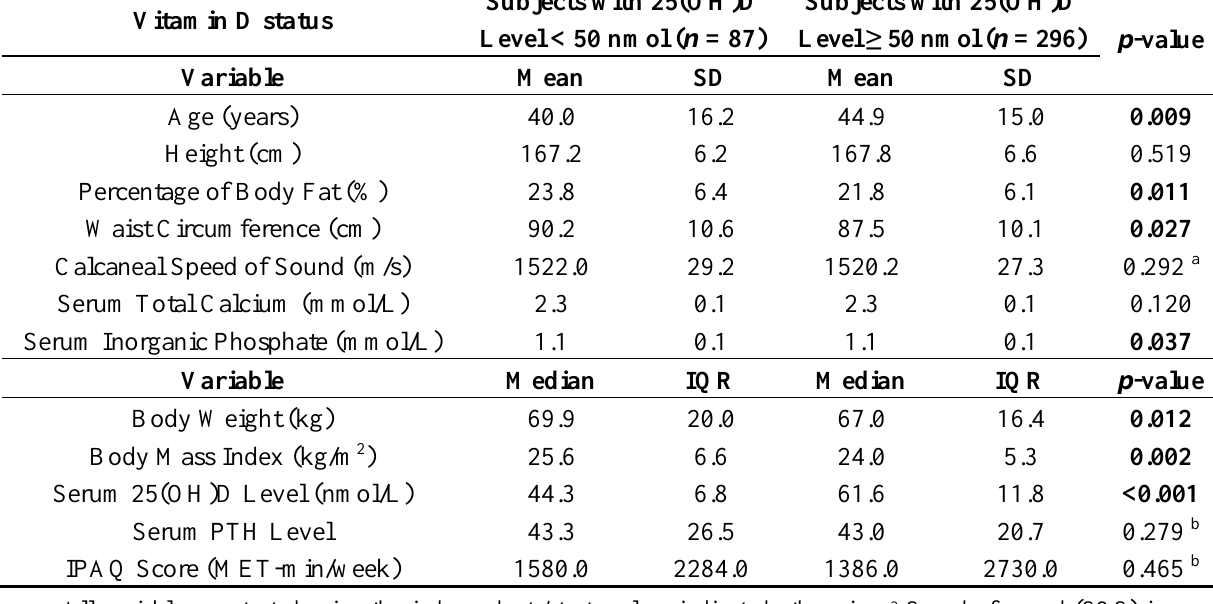
Table 2. The difference in characteristics between subjects with an optimal (≥50 nmol)